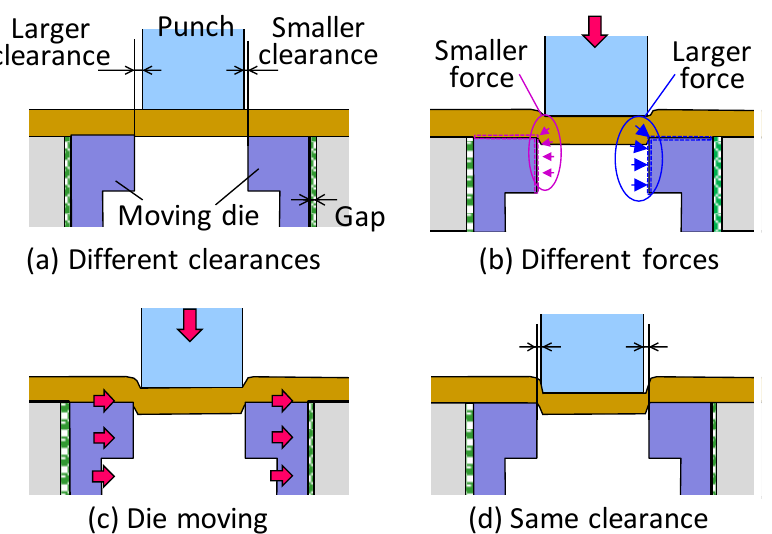
Figure 10. Slight clearance punching process with punch having small round corner using automatic centring with moving die; ( a ) different clearances, ( b ) different forces, ( c ) die moving and ( d ) same clearance [56].